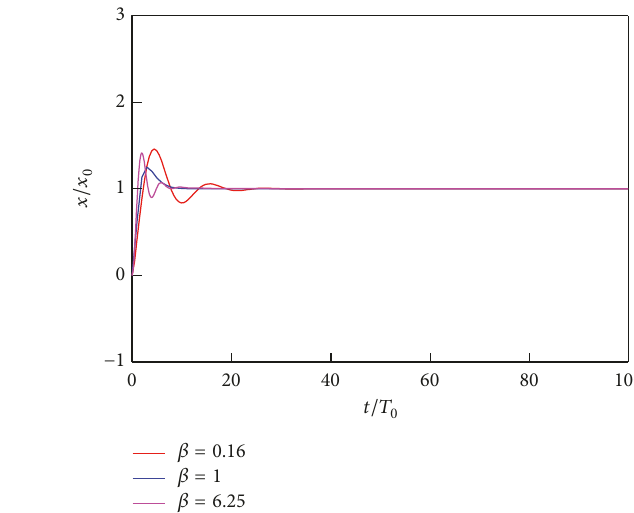
Figure 23: Response in the time domain (𝛼 = 3, 𝛽 = 0.16, 1,6.25) .